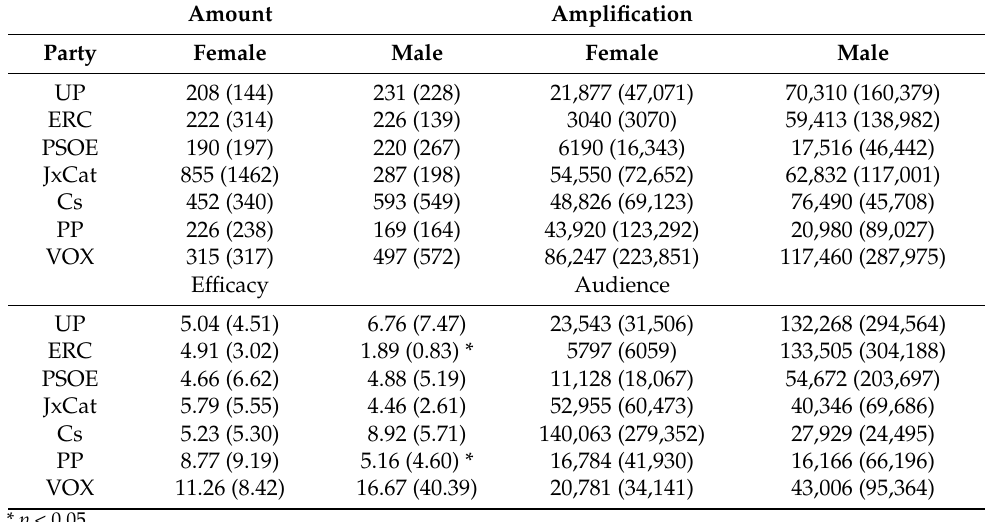
Table 4. Mean amount, amplification, efficacy and audience of Spanish Members by gender and party.